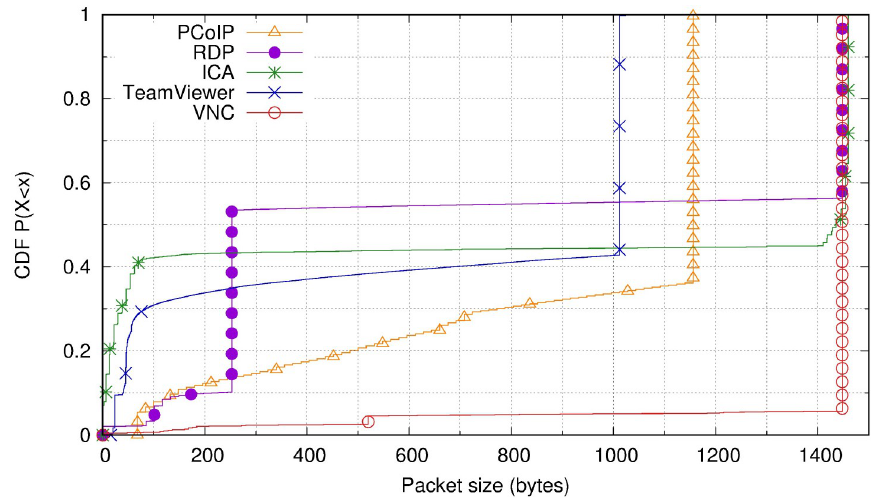
Fig 11. Packet size cumulative distribution function for all remote desktop